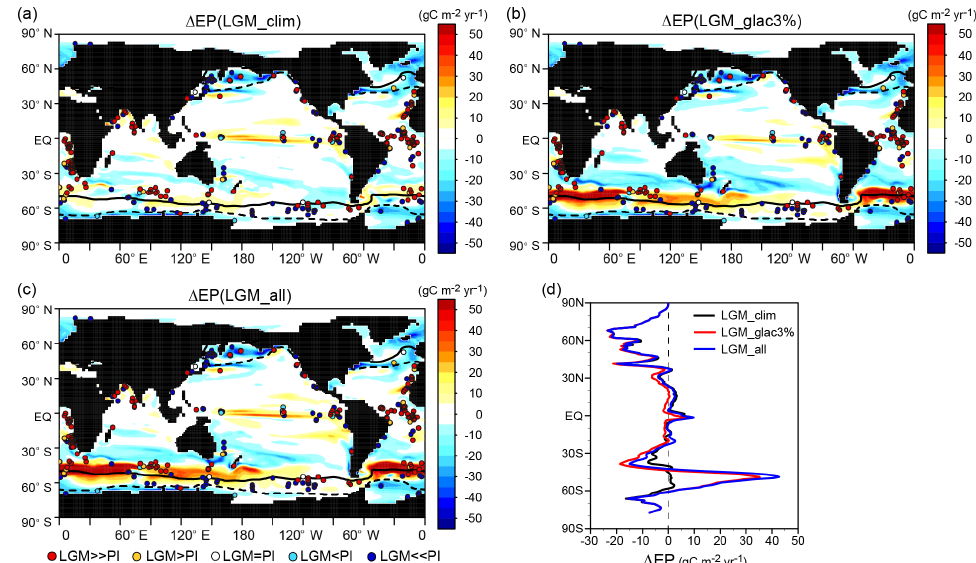
Figure 3. Model–proxy comparison of EP change from the PI to LGM. The EP difference from the PI for (a) LGM_clim, (b) LGM_glac3%, and (c) LGM_all. Circles show proxy data (Kohfeld et al., 2013). Solid (dotted) lines refer to the glacial sea-ice fraction of 0.1 during August (February). (d) Zonal mean changes in the surface EP from the PI for LGM_clim (black), LGM_glac3% (red), and LGM_all (blue).